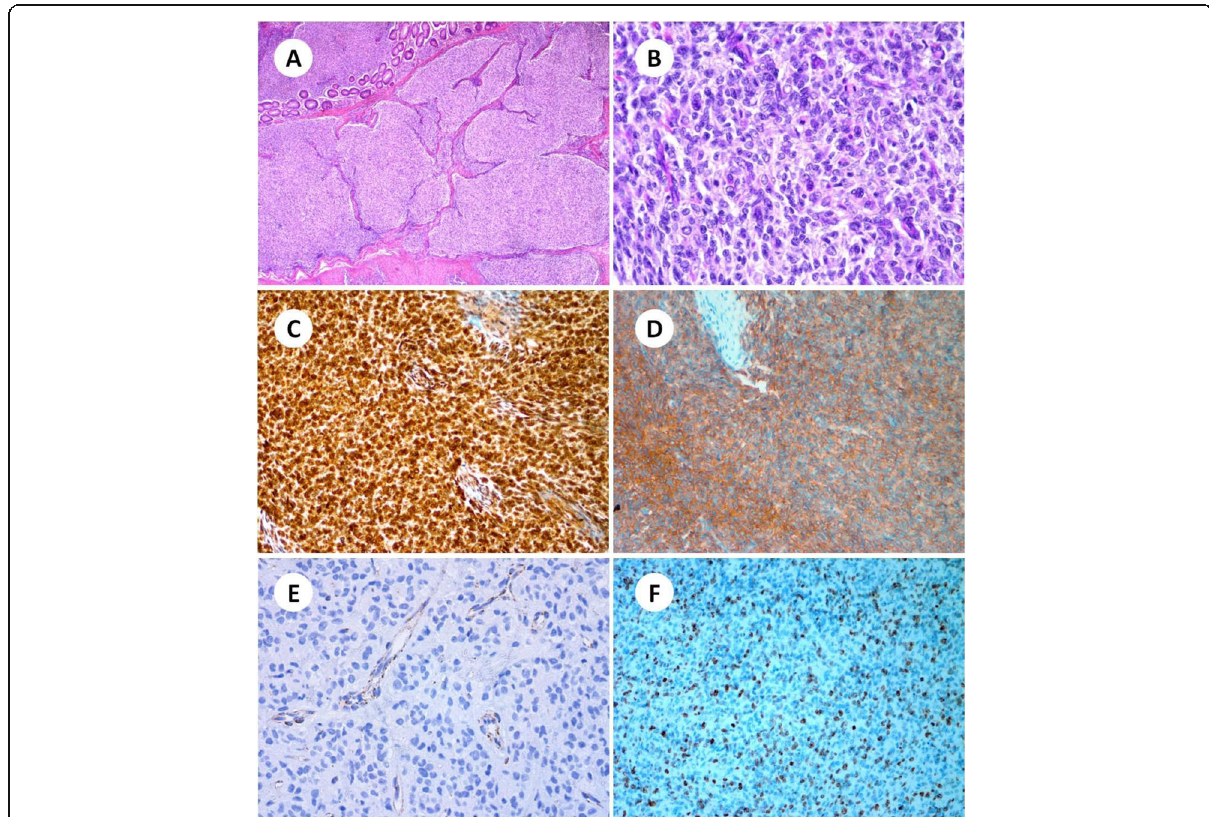
Fig. 2 The microscopic features and immunohistochemical stains of the lesion. a : Tumors are distinctive in their multinodular colon wall involvement with interspersed tracts of colon wall smooth muscle (H&E, × 100). b : The tumor cells have a mainly epithelioid cytology with variably eosinophilic cytoplasm. Mitotic images were easy to be seen (H&E, × 400). c : PDGFR was diffusely and strongly positive (× 200). d : The tumor cells were positive for CD117 (× 200). e : The tumor cells lack SDHB expression, but vascular elements were positive (× 400). f : The Ki-67 labelling index (MIB-1 index) reached 30% in the area of greatest concentration (×